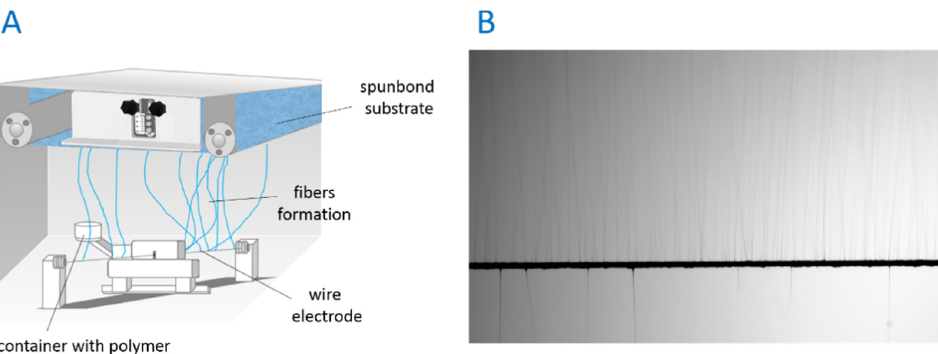
Figure 1. Needleless electrospinning device ( A ). The fiber formation process on the wire electrode ( B ).